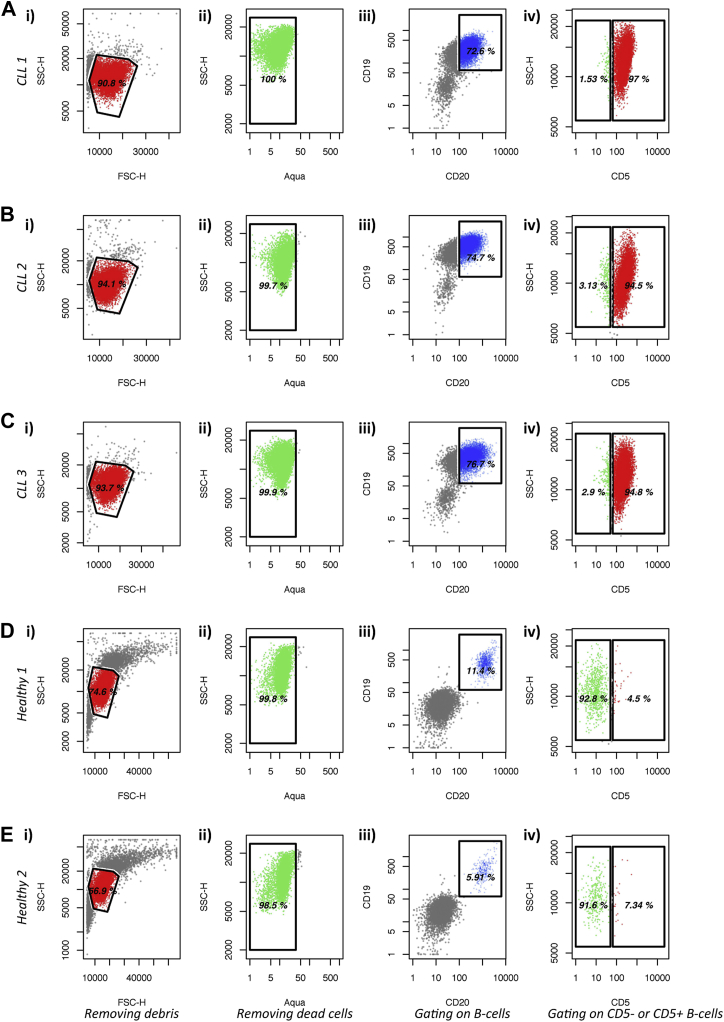
Single-cell flow sorting of CD5high and CD5low B cells. The gating strategy used for identification of CD5high and CD5low mature peripheral blood B cells in the single-cell experiments for (A) CLL patient 1, (B) CLL patient 2, (C) CLL patient 3, (D) healthy individual 1, and (E) healthy individual 2. After exclusion of debris using light scatter features of leukocytes (panels (i)) and exclusion of dead cells (panels (ii)), mature B cells were identified as CD19+CD20+ (panels (iii)). Events captured in the red gate in panels (iv) were identified as CD5high, and those captured in green gate were identified as CD5low. Gates were chosen based on bead experiments (Supplementary Fig. E1).